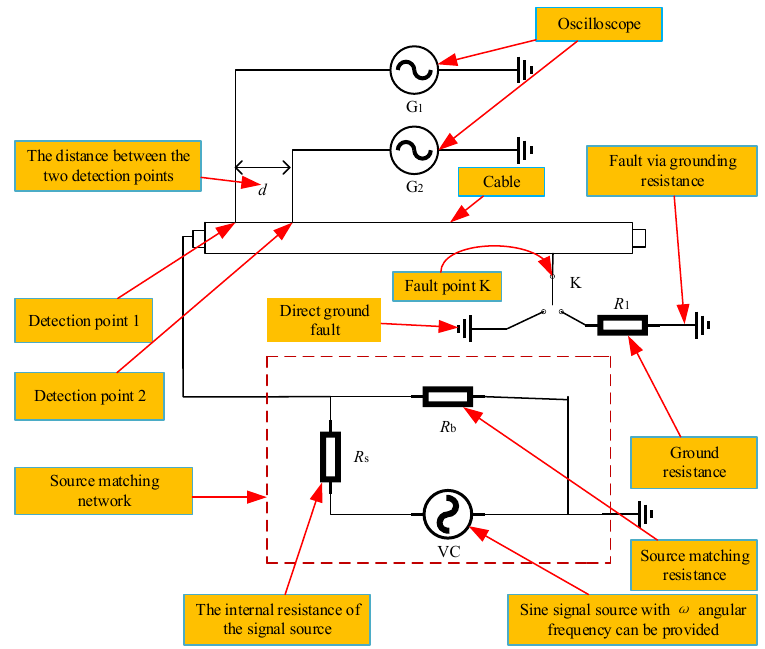
Figure 2. Schematic diagram of fault location circuit.